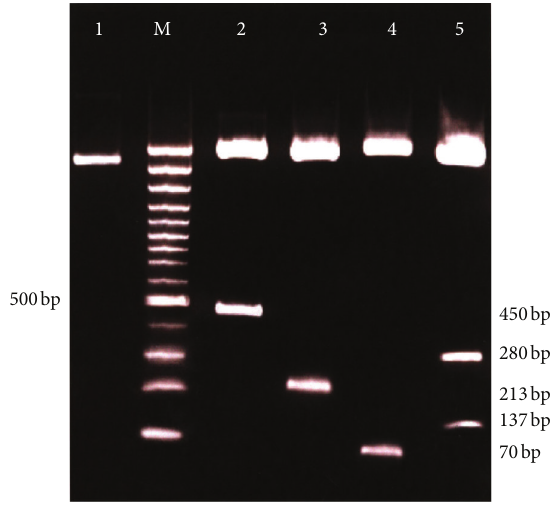
Figure 1: Characterization of recombinant plasmid containing nil- gai IL4 by PCR and restriction digestion. L1: linearised recombinant plasmid using BamHI enzyme, M: 100 bp DNA ladder, L2: insert release using Not I enzyme, L3: Pst I digest, L4: Nco I digest, and L5: Eco RI